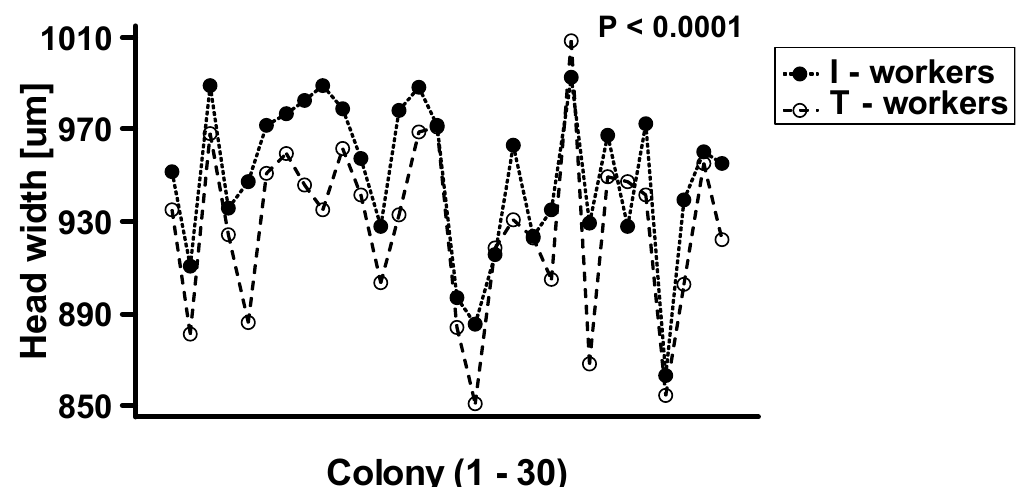
Figure 3. The plot of interaction between worker class and colony (N = 30) on the mean body size of Lasius niger . T-workers-foraging workers attracted to tuna baits, I-workers-workers collected directly from the nest.